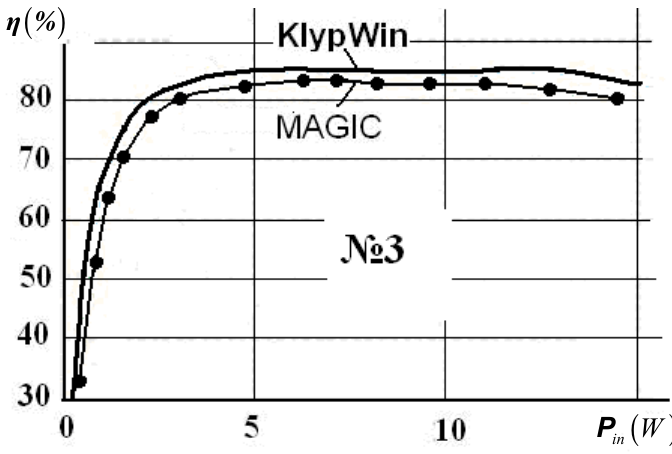
Figure 6. Comparison of the transfer curves of the klystron № 3 Figure. 5.